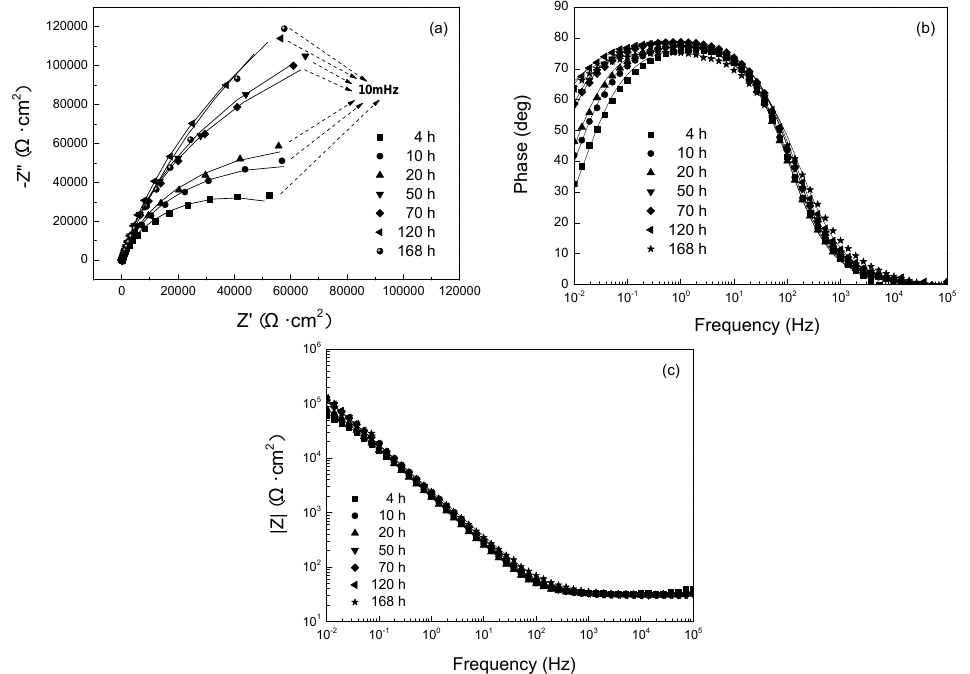
Figure 6. EIS evolution of 304 SS under the polarization potential of − 0.50 V in sea water. Nyquist plot ( a ), Bode plot ( b , c ), in which symbol are measured data, line are simulated data. Table 3. Fitting parameters for EIS spectra of 304 SS under polarization at − 0.50 V.